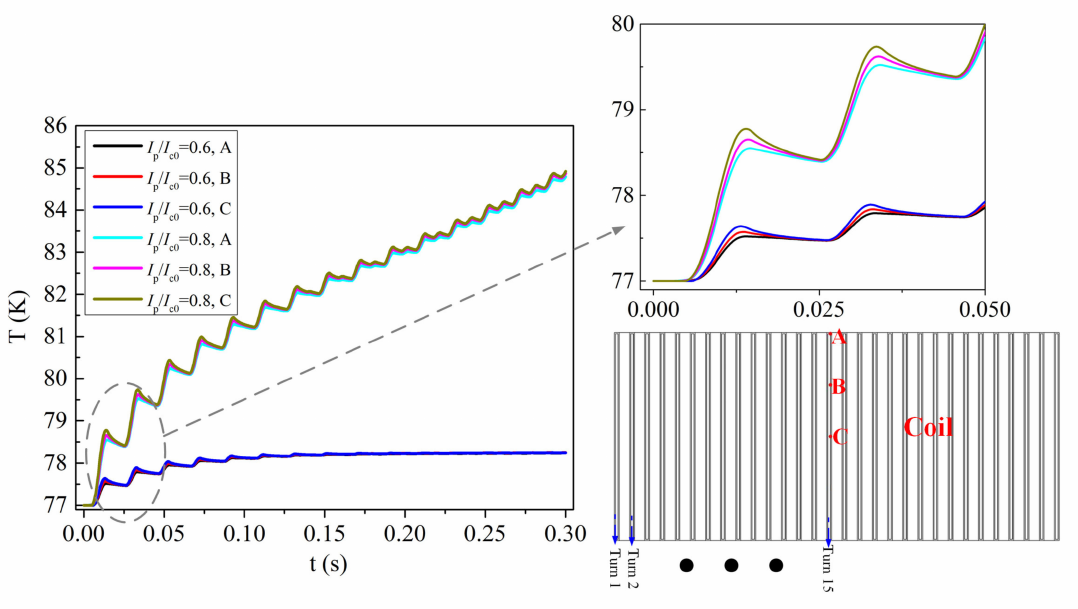
Figure 10. The temperature at the 15th turn of the tape in the coil changes with time at positions A, B and